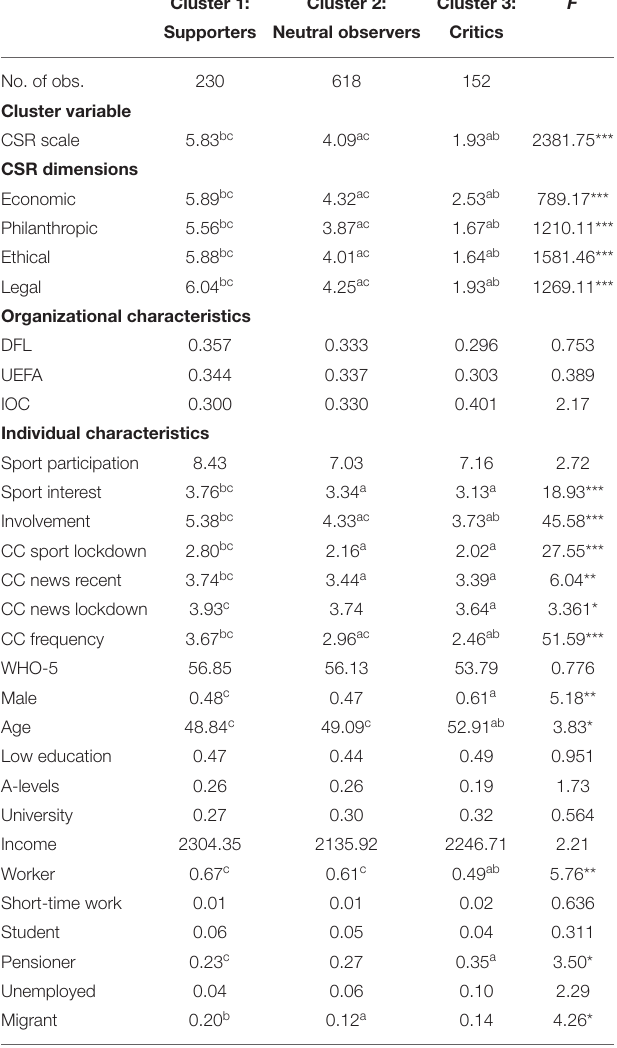
TABLE 10 | Results of cluster analysis and post-hoc test (displayed are the mean values). Cluster 1: Cluster 2: Cluster 3: